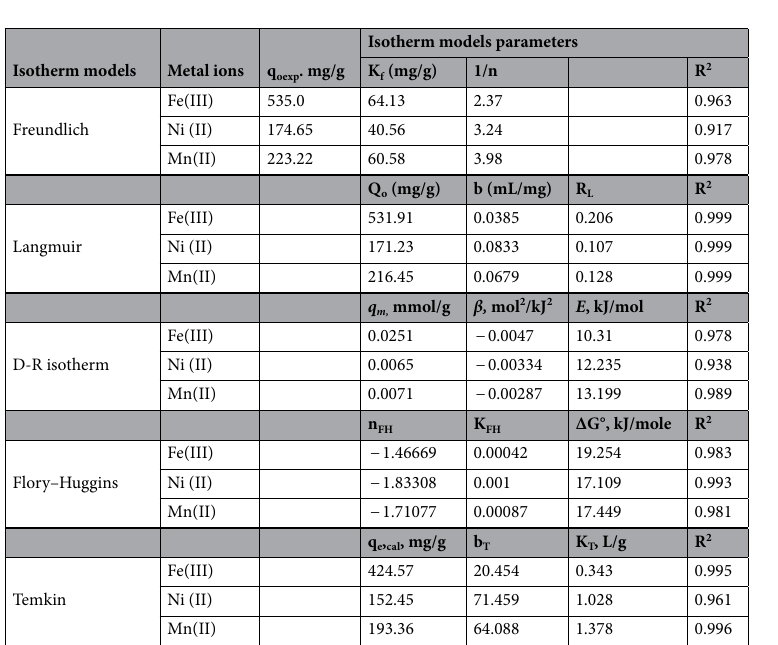
Table 3. Calculated parameters of the linear Freundlich, Langmuir, D-R, Flory–Huggins and Temkin isotherm models for Fe 3+ , Ni 2+ , and Mn 2+ sorbed onto the modified (GO-C).